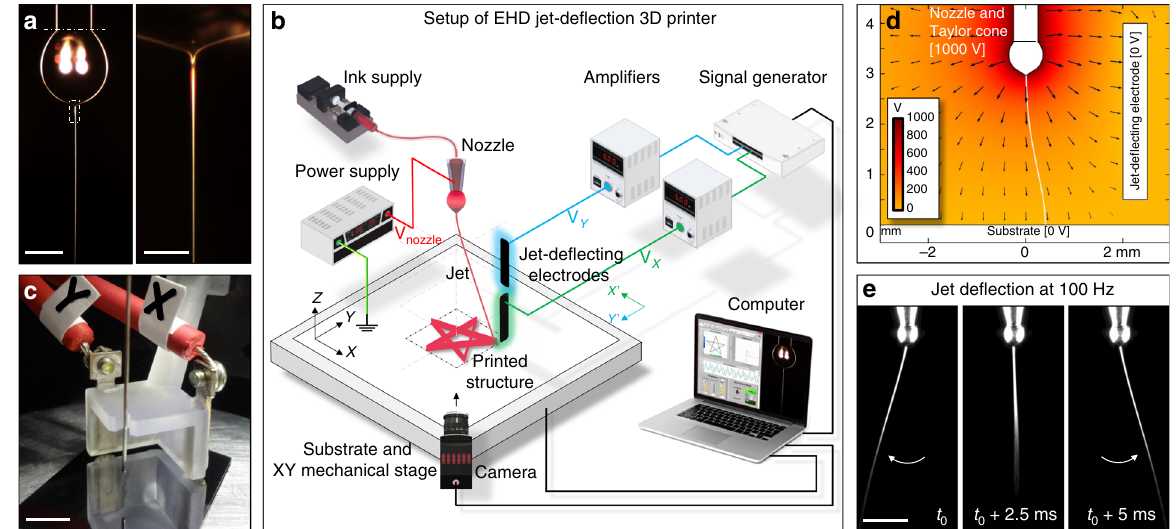
Fig. 1 The electrostatic control of the jet trajectory. a Optical photographs of the nozzle, ink drop (below dotted line), Taylor cone, and the electri fi ed jet generated by applying 1000 V between the nozzle and a printing substrate (not shown). Scale bars: 500 µ m and 50 µ m. b Schematic of an EHD 3D printer with jet-de fl ecting electrodes. c Set of jet-de fl ecting electrodes and needle used as nozzle. Scale bar: 5 mm. d Simulation of the electric potential and fi eld around the jet in the presence of a jet-de fl ecting electrode. The de fl ecting electrode, nozzle and ink drop are shown in white for clarity but are at the speci fi ed potentials. The electric fi eld streamline (also in white) starting at the tip of Taylor cone represents the theoretical trajectory of a massless jet. Additional simulation results can be found in the supplementary material, Supplementary Fig. 1 and Supplementary Movie 3. e High-speed video captures of the jet being de fl ected in 1D with a frequency of 100 Hz (video showing jet de fl ection at 10, 50 and 100 Hz can be found in the supplementary material, Supplementary Movie 1). Two jet-de fl ecting electrodes (not shown) were used, positioned on the left and on the right side of the video captures. Video captures show the nozzle, the Taylor cone at the end of the ink drop and the thin jet expelled. The trajectory of this jet and thus its point of arrival to the substrate were modulated by the voltage applied to the jet-de fl ecting electrodes. Scale bar: 500 µ